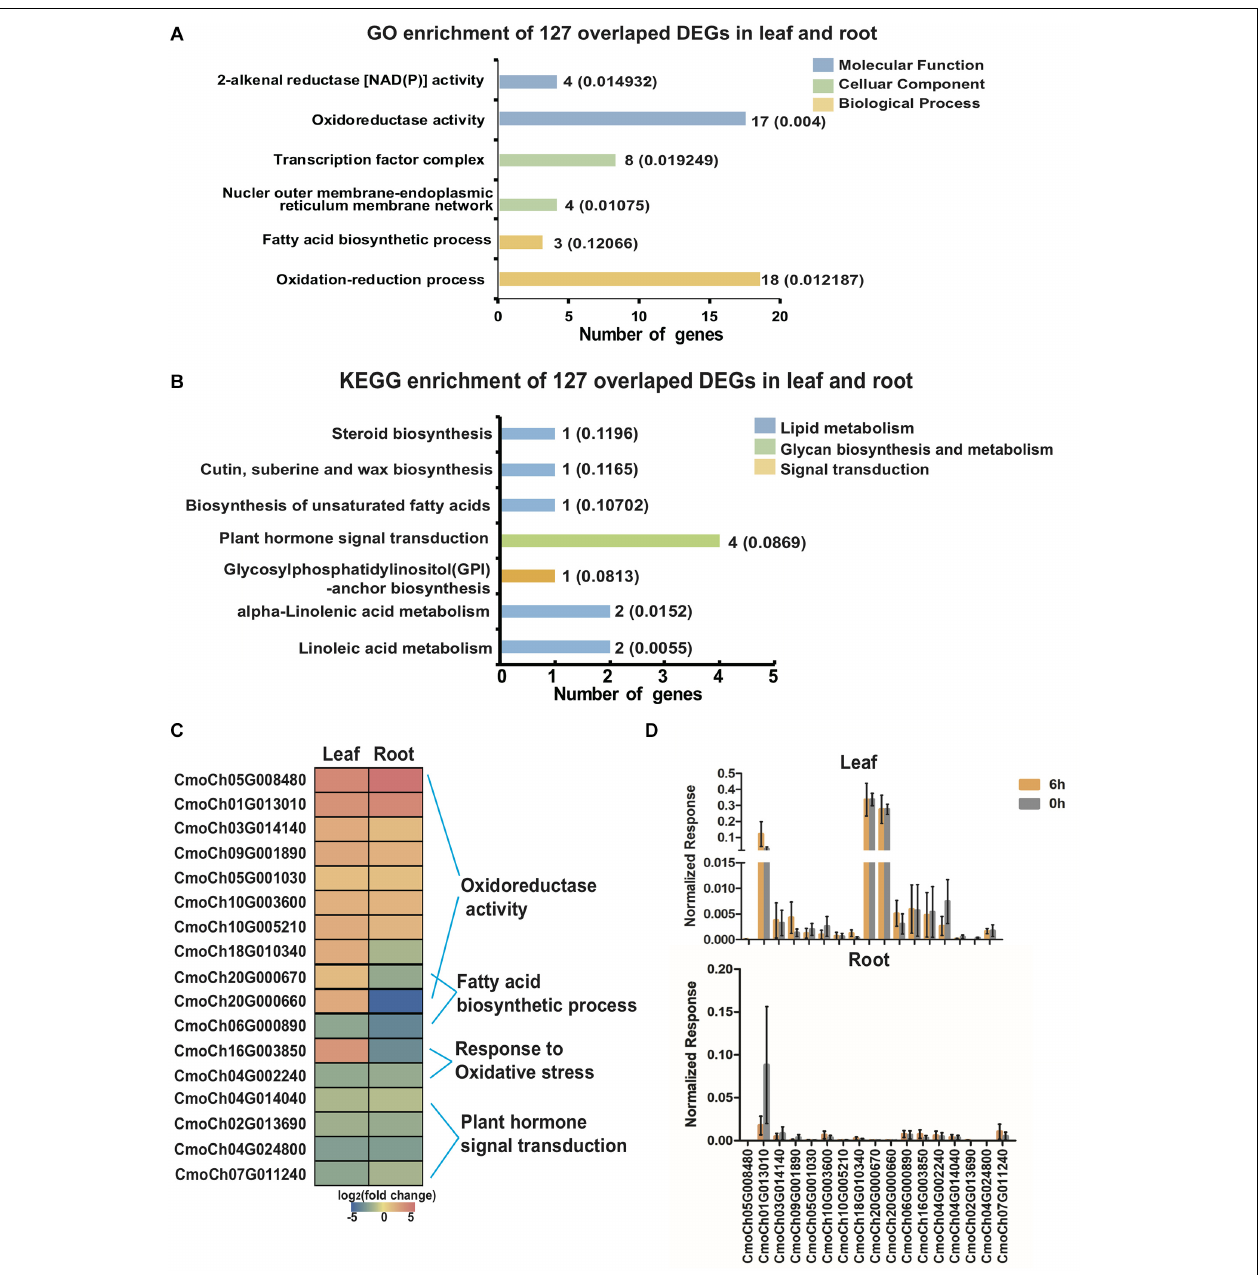
FIGURE 6 | GO enrichment, KEGG pathway annotation and 127 selected overlapped CmoDEGs in leaves and roots. (A) GO enrichment and (B) KEGG pathway annotation of 127 overlapped CmoDEGs in leaves and roots. Colored graphs indicate the classifications of molecular function, cellular component and biological process. The numbers beside the graphs represent the number of genes in the cluster and the p -value. (C) Heat map of the top upregulated 14 DEGs in leaves and roots. These are enriched for oxidoreductase activity, fatty acid biosynthesis and responses to oxidative stress pathways. (D) The normalized FPKM level of 14 genes in leaf and root tissues. Each sample includes three replicates for the transcriptome data. Error bars indicate